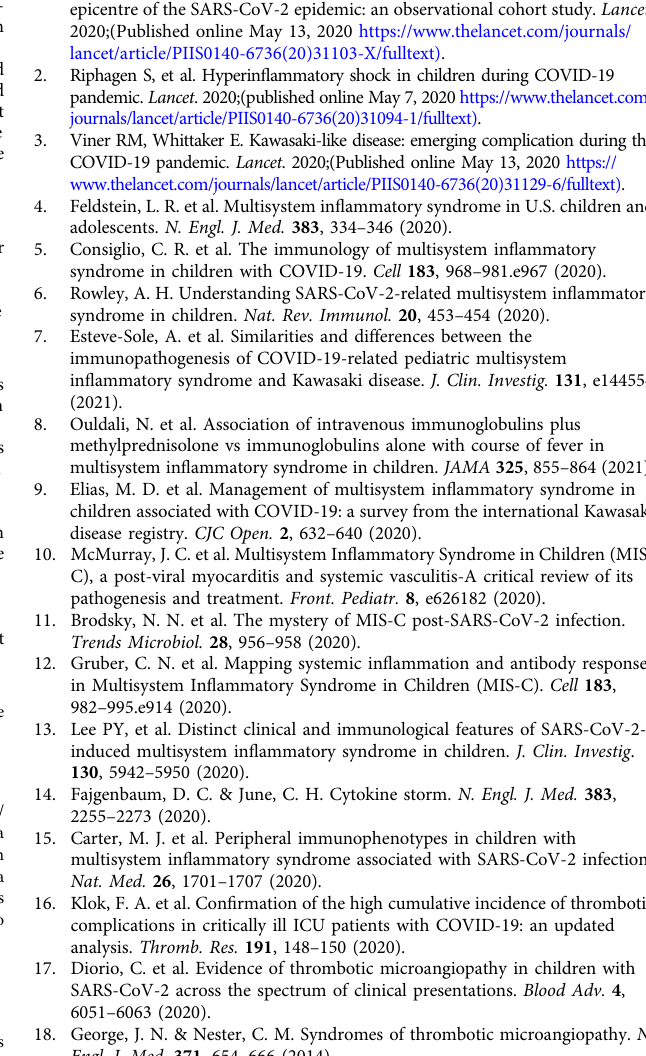
Fig. 6 Clinical heterogeneity among MIS-C patients de fi ned by their IFN γ signature. a Overlaps between patients who meet criteria for macrophage activation syndrome (MAS), thrombotic microangiopathy (TMA), and MIS-C. b Differentially expressed proteins between patients with IFN γ -low ( N = 13) and IFN γ -high expression ( N = 7). Log2fold change threshold of 2 and a nominal p -value cutoff of 0.05 were used. c Unsupervised pathway ranking and d network analysis for differentially expressed proteins between IFN γ -low and IFN γ -high patients. e Maximum ferritin level during admission for patients in the IFN γ -low ( N = 12) and IFN γ -high ( N = 7) groups. P -value computed using Wilcoxon test. Horizontal line represents median, with bounds of box representing interquartile range. Whiskers represent 1.5x the interquartile range. Dots represent outliers. f Number of patients in IFN γ -low ( N = 13) and IFN γ -high ( N = 7) groups who did and did not require inotropic support. P -value computed with Fisher ’ s exact test. NTproBNP expression between IFN γ - low ( N = 13) and IFN γ -high groups ( N = 7) ( g ) and in MIS-C patients who did ( N = 7) and did not require inotropes ( h ; N = 15). Horizontal line represents median, with bounds of box representing interquartile range. Whiskers represent 1.5x the interquartile range. Dots represent outliers. i Correlation between IFN γ level and percent DR + CD38 + non-naïve CD8 + CX3CR1 + T cells in MIS-C patients ( N = 7). Dots colored by CX3CL1 expression. R value computed using Pearson ’ s correlation coef fi cient after normality was demonstrated. Error band represents 95% con fi dence interval. j CX3CL1 levels between IFN γ - low ( N = 13) and IFN γ -high groups ( N = 7). P -values computed with Wilcoxon test. Horizontal line represents median, with bounds of box representing interquartile range. Whiskers represent 1.5x the interquartile range. Dots represent outliers. All p -values were calculated using two-sided tests. Source data are provided as a Source Data fi